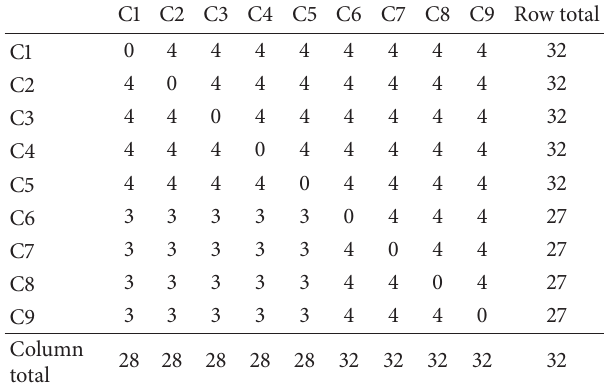
Table 8: The average matrix of model 3.